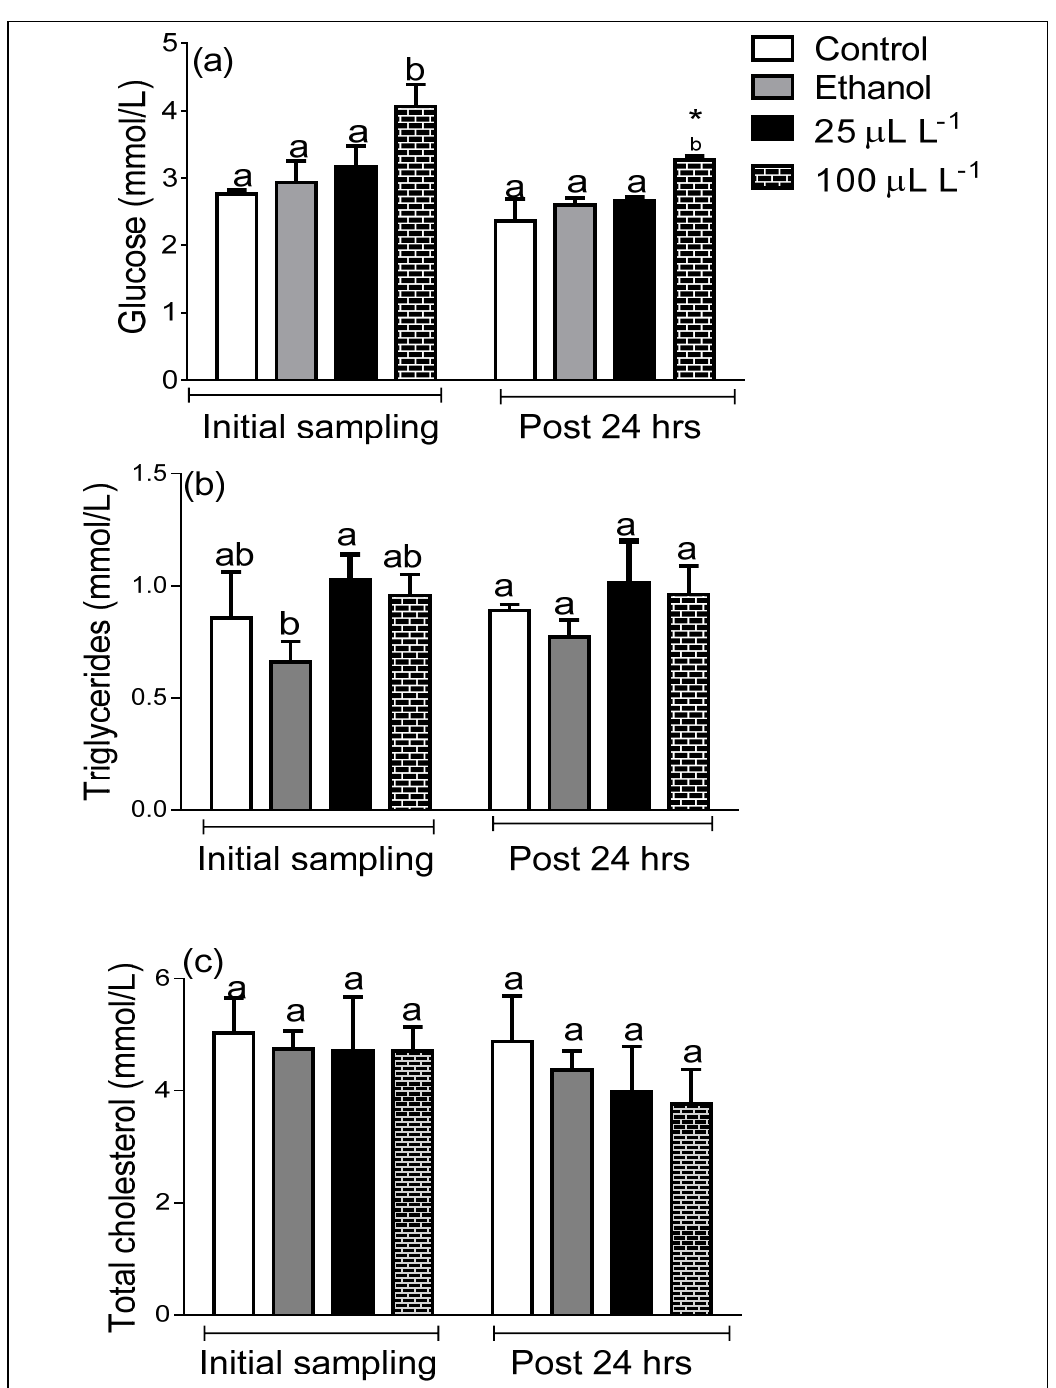
Figure 2. Blood glucose ( a ), triglycerides ( b ), and total cholesterol ( c ) of Mozambique tilapia ( Ore- ochromis mossambicus ) subjected to two oregano concentrations (25 and 100 µ L L − 1 ), ethanol, and a control (water only). These parameters were sampled at 0 h and after 24 h. Values are given as mean ± standard error ( N = 3), and different lowercase letters indicate significant differences between treatment groups within a sampling time (0 h or 24 h) using one-way ANOVA and Tukey’s multiple comparison test. The asterisks indicate a significant difference of the treatment group from other groups after 24 h ( p < 0.05).